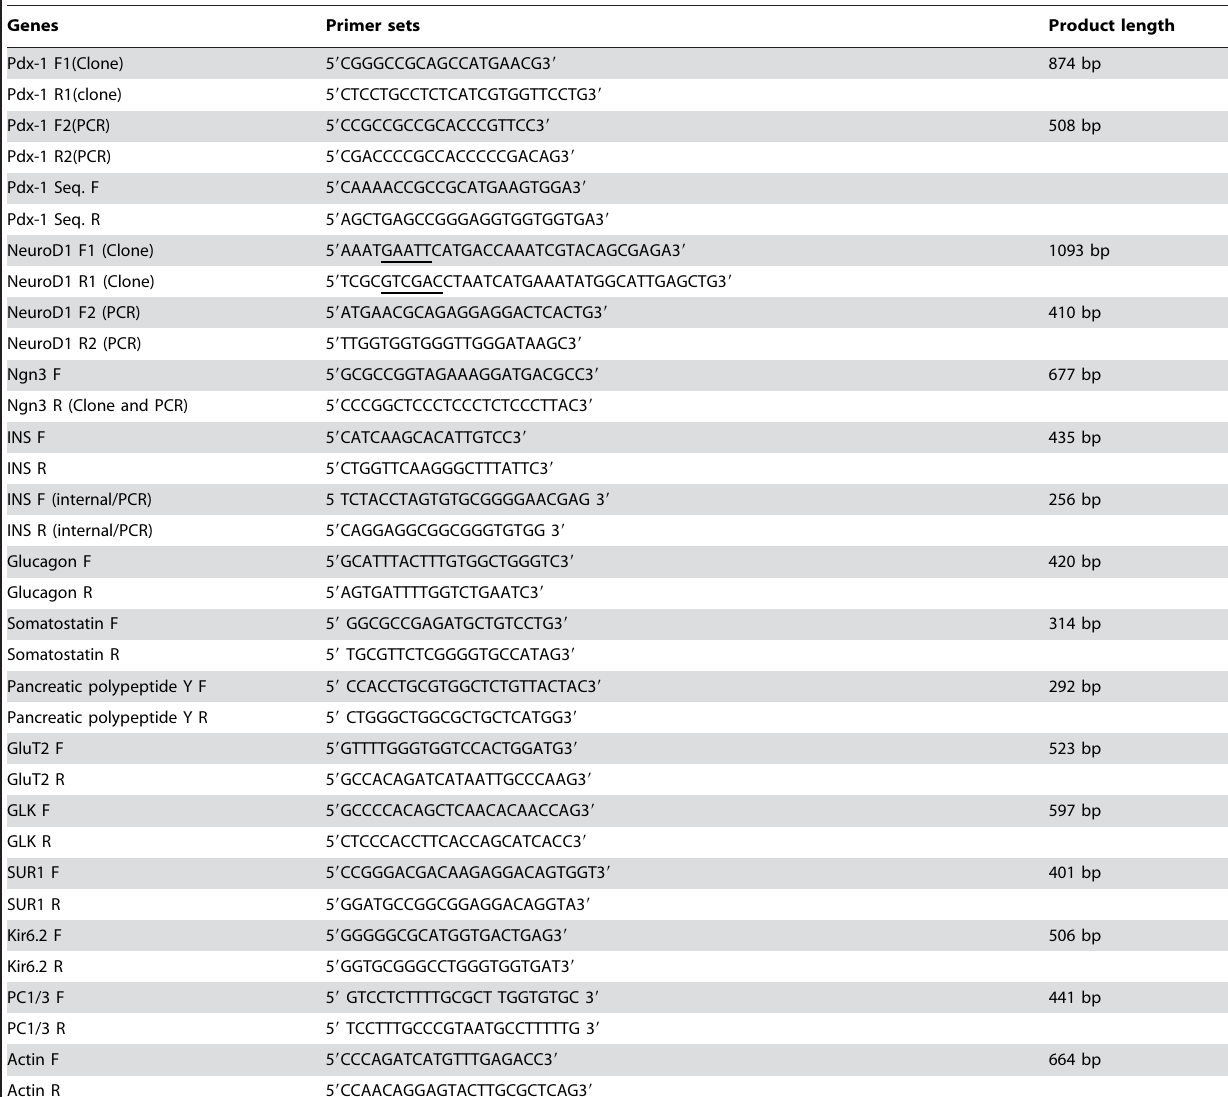
Table 1. Primer sets for cloning, PCR and sequence